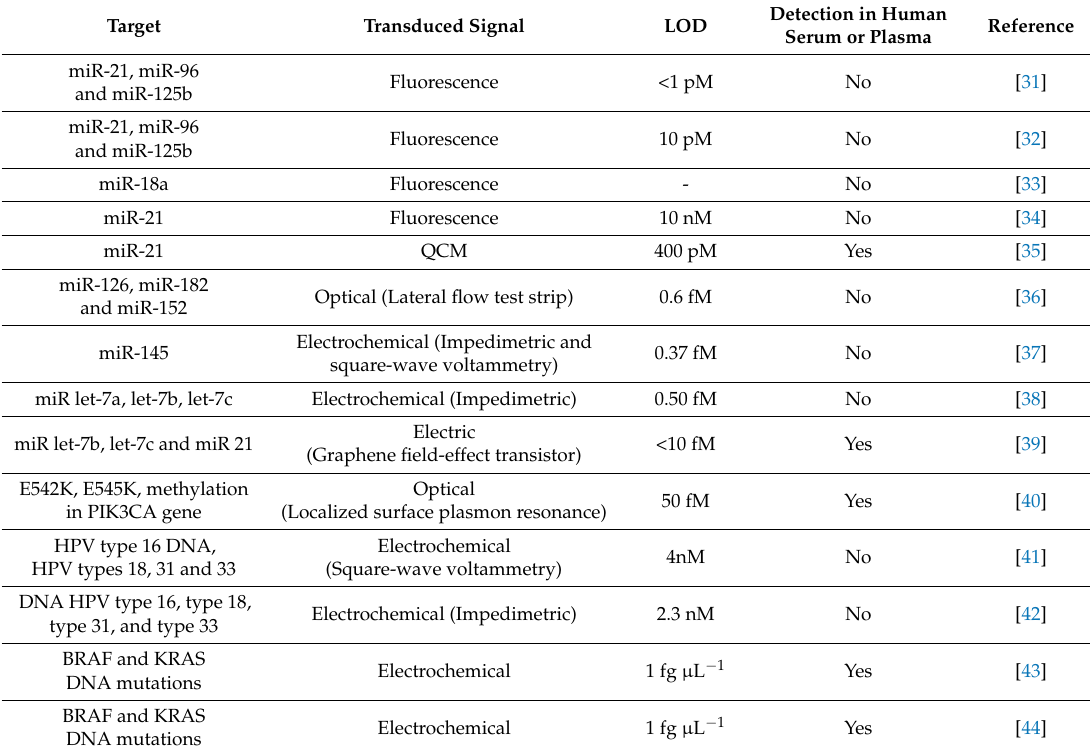
Table 1. Overview of PNA-based biosensors for the detection of RNA or DNA cancer biomarkers.